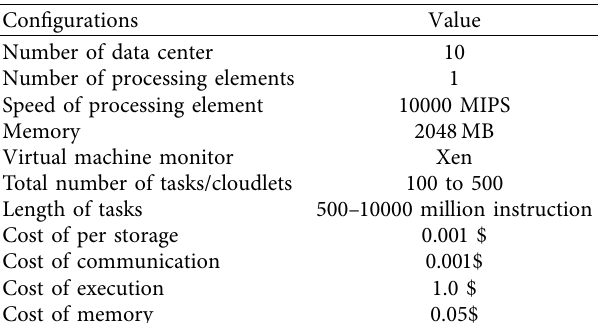
Table 3: Configuration and simulation parameters on cloud sim. Configurations Value Number of data